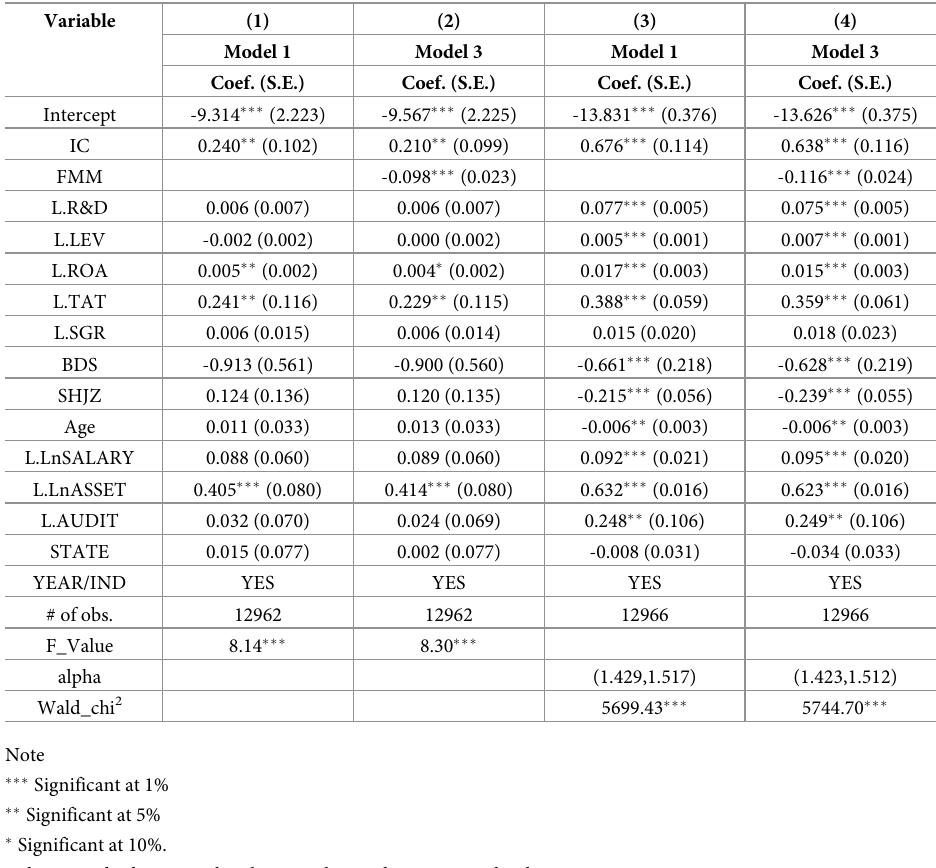
Table 7. Regression results for re-measuring innovation